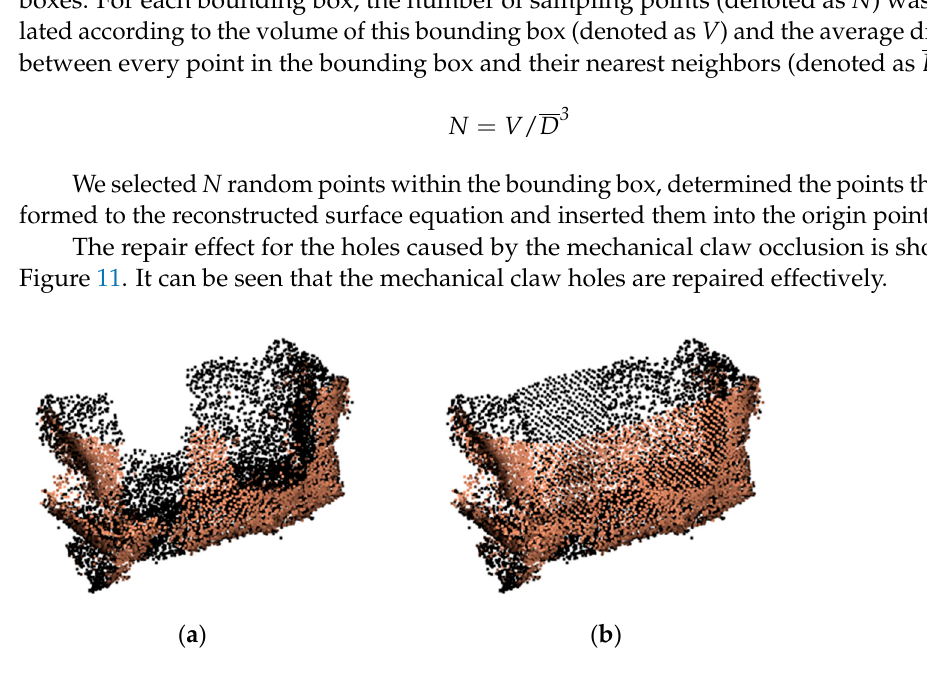
Figure 11. Example of mechanical claw hole repair result: ( a ) before repair; ( b ) after repair.